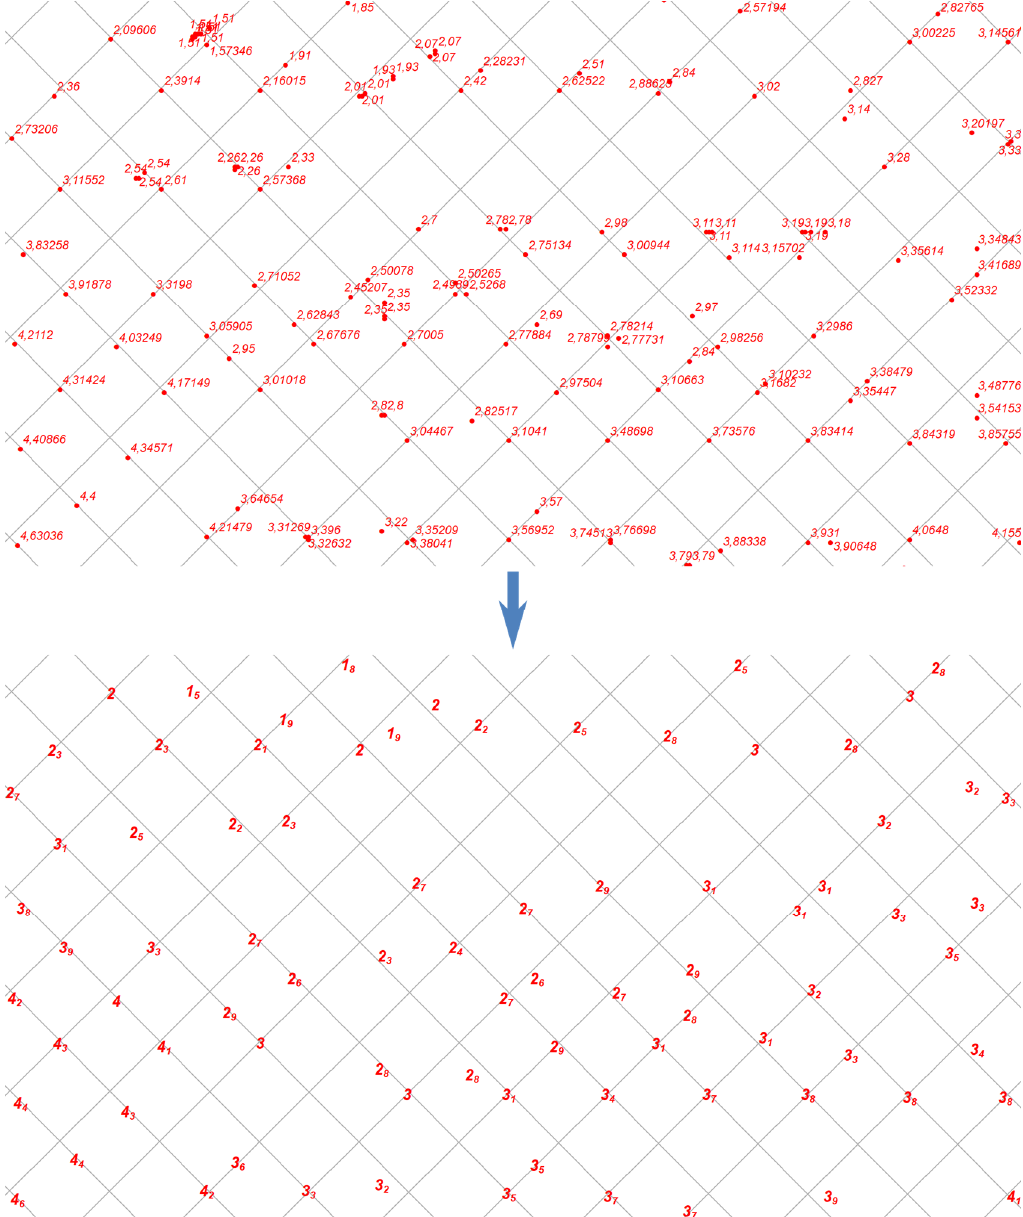
Figure 2. Prime soundings (shoals) selection: (top image) selected soundings based on shoal criteria and (bottom image) retained soundings based on distance criteria.